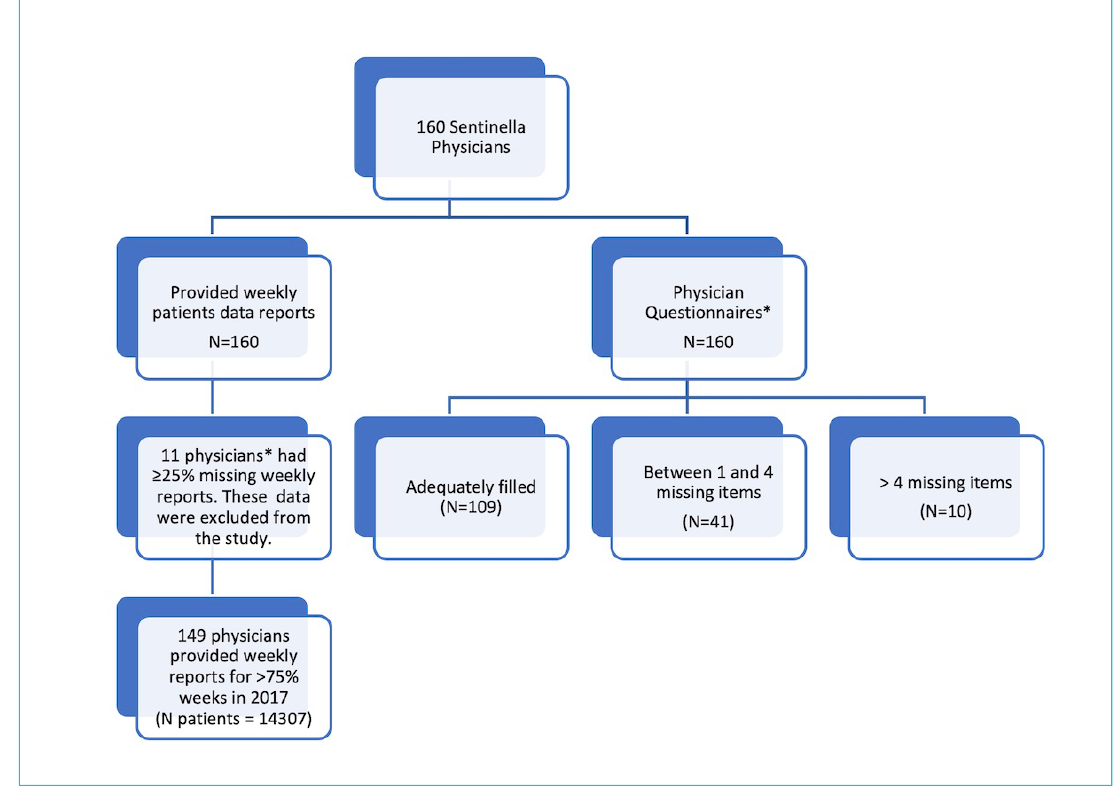
Figure 1: Summary of the data collection. * Characteristics of physicians with missing weekly reports were included in the analysis of the physician